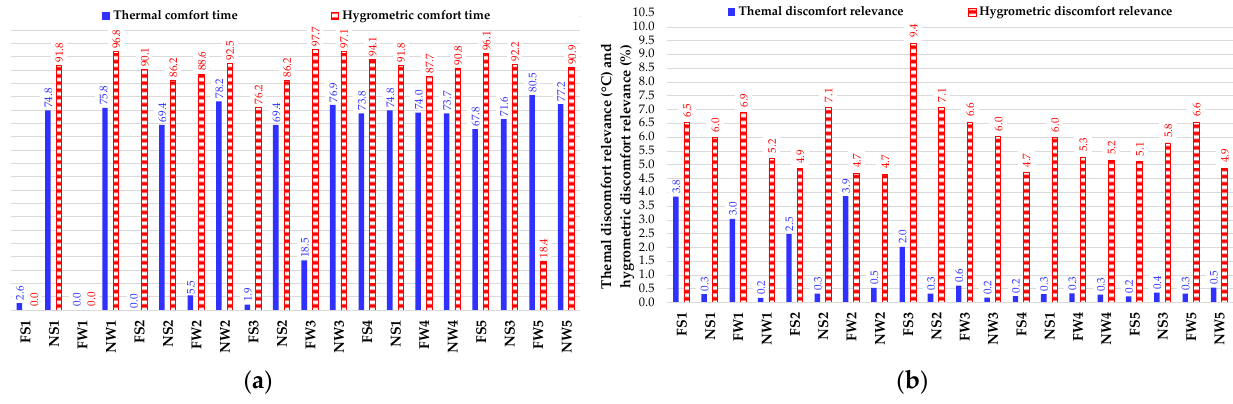
Figure 4. ( a ) Thermal/hygrometric comfort time, ( b ) Thermal/hygrometric discomfort relevance as a function of the tests.